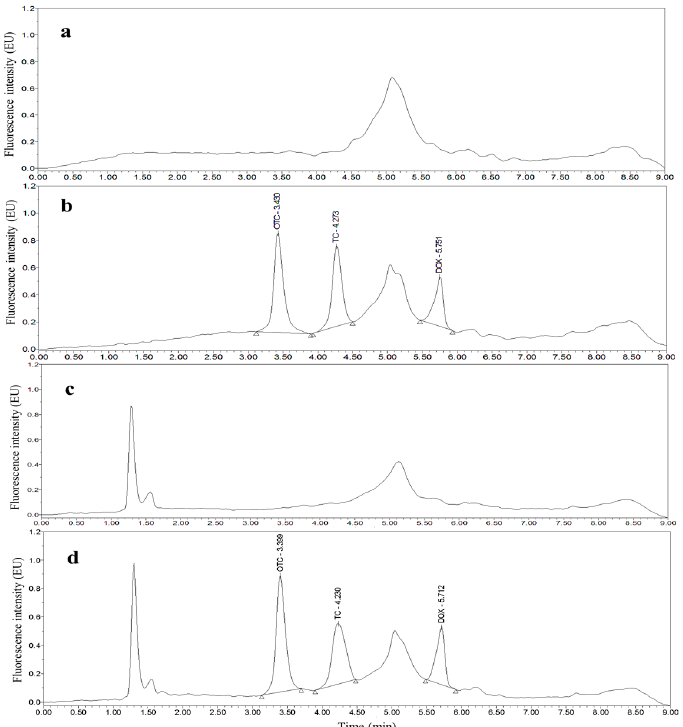
Figure 1. Chromatograms of the mobile phase ( a ), 200 μ g/kg OTC, TC and DOX standards ( b ), blank blended whole chicken egg ( c ) and blank blended whole chicken egg spiked with 200 μ g/kg OTC, TC and DOX standards ( d ) from channel A.